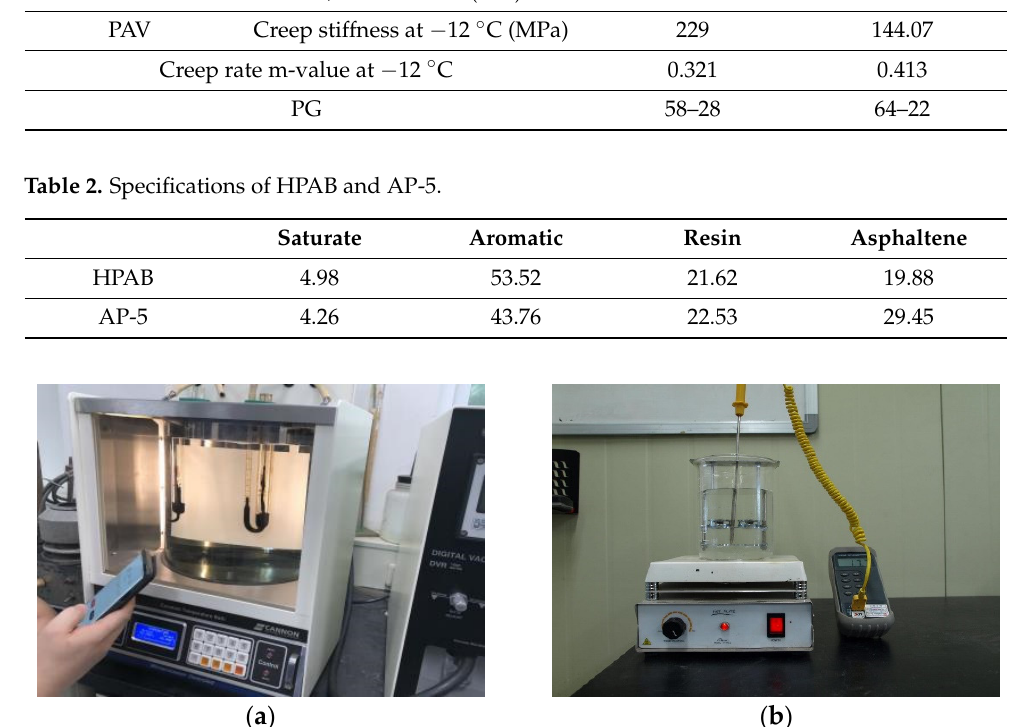
Figure 1. Laboratory device for properties test: ( a ) absolute viscosity, and ( b ) softening point.